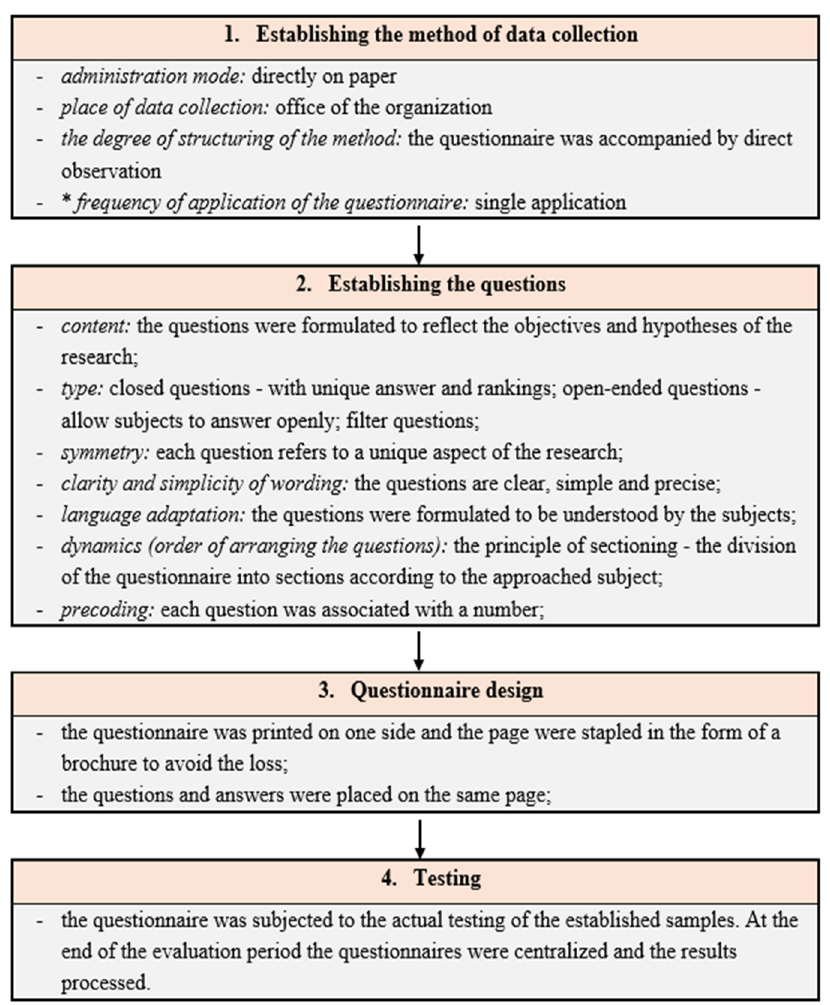
Figure 2. Stages of designing questionnaires ((Jiang and Prabhu 2008), Figure 4, p. 1584).